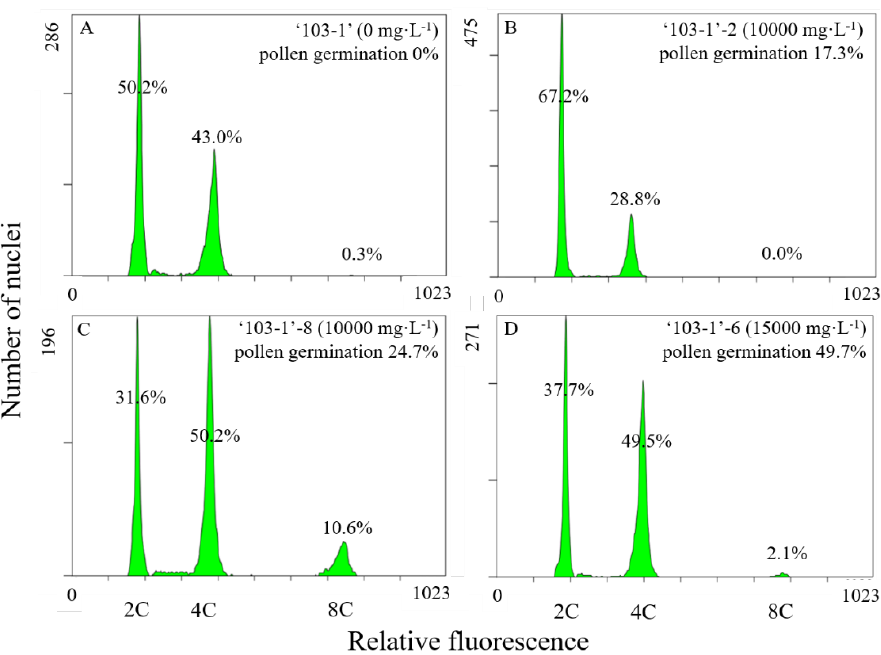
Figure 7. Flow cytometric patterns of leaves obtained from ‘103-1’ hybrid ( Kalanchoe garambiensis ‘Type 1’ × K. nyikae ) and colchicine-treated ‘103-1’ clones. ( A ) Control, ‘103-1’ treated with lanolin only without colchicine. ( B , C ) are ‘103-1’-2 and ‘103-1’-8, respectively. Both clones were obtained from ‘103-1’ after treatment with 10,000 mg · L − 1 colchicine in lanolin. ( D ) shows ‘103-1’-6, which were obtained from ‘103-1’ after treated with 15,000 mg · L − 1 colchicine in lanolin.